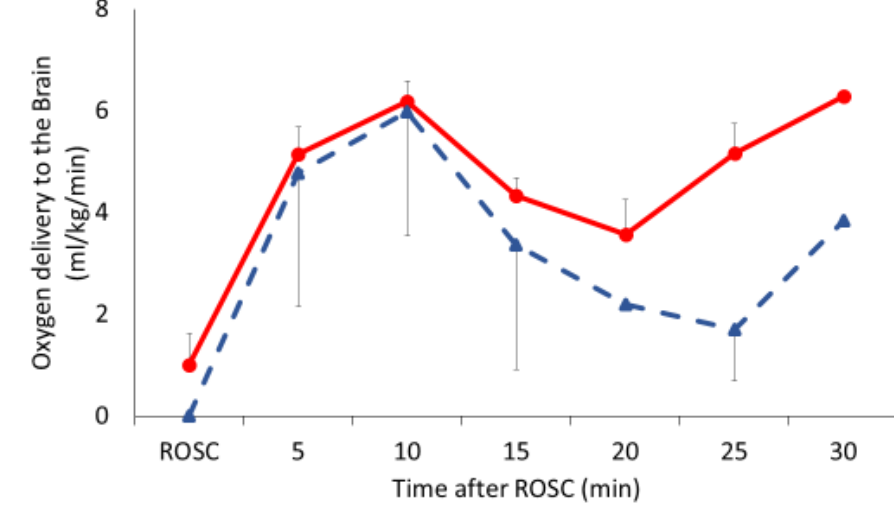
Figure 6. ( A ) Oxygen delivery to the brain during chest compression using the antegrade systolic carotid blood flow represented as a bar graph. ( B ) Oxygen delivery to the brain after return of spontaneous circulation. Interrupted line represents 21% and continuous line 100% oxygen. Data presented as average and standard deviation.